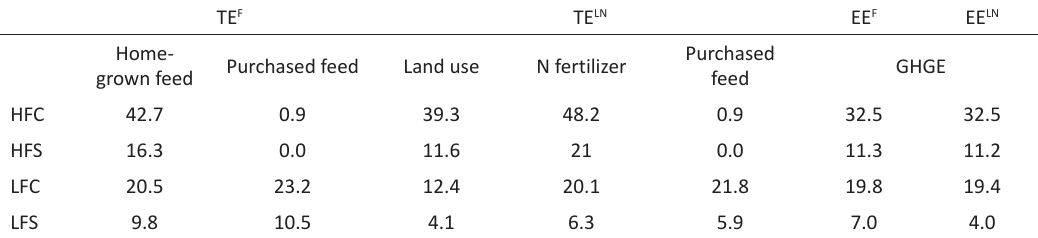
Table 3. Input and undesirable output savings potentials per system and efficiency type. TE F TE LN EE F EE